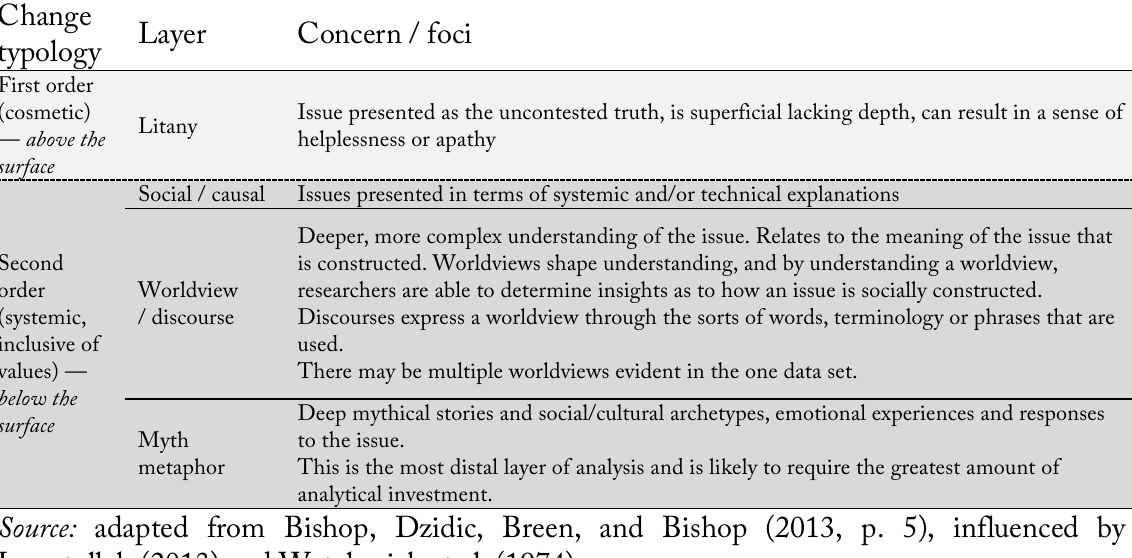
Table i: Causal layered analysis, contextualised by first and second order